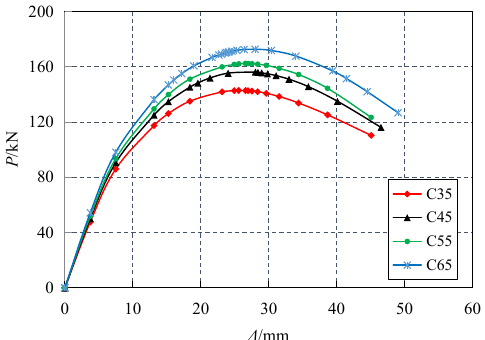
Figure 17. Influence of RAC strength on composite joints. Table 5. Influence of RAC strength on characteristic points of composite joints.